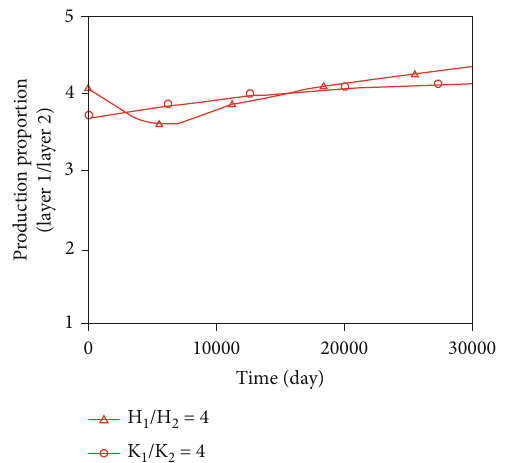
Figure 7: The numerical simulation results of controlling the same KH ratio, K 1 H 1 /K 2 H 2 = H 1 /H 2 = K 1 /K 2 = 4 .